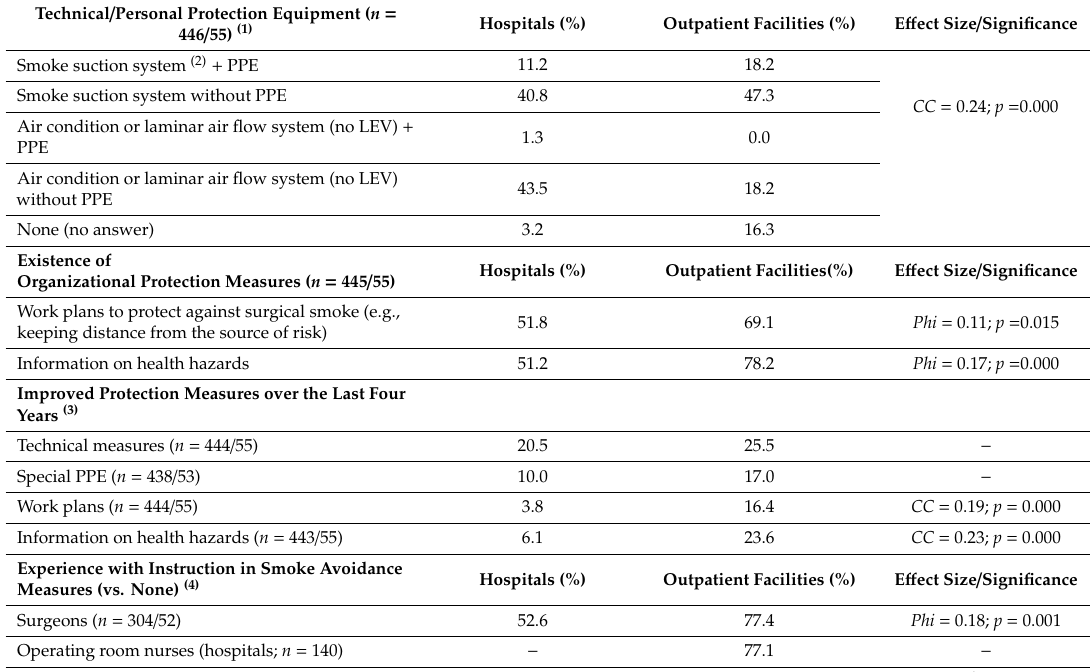
Table 3. Existence of technical, personal, and organizational protection measures and instructions regarding smoke avoidance